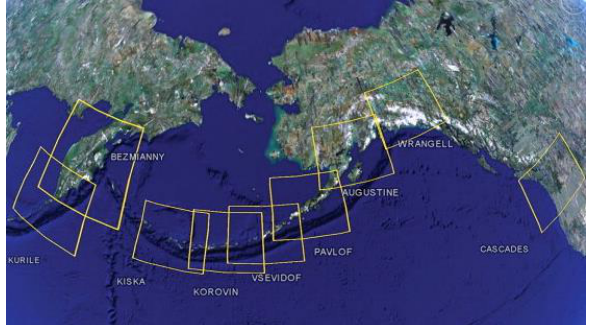
Figure 2. Geographic sectors that are used to organize remote sensing data in the AVO system. Sector outlines and sector names are shown (adapted from Webley et al.,